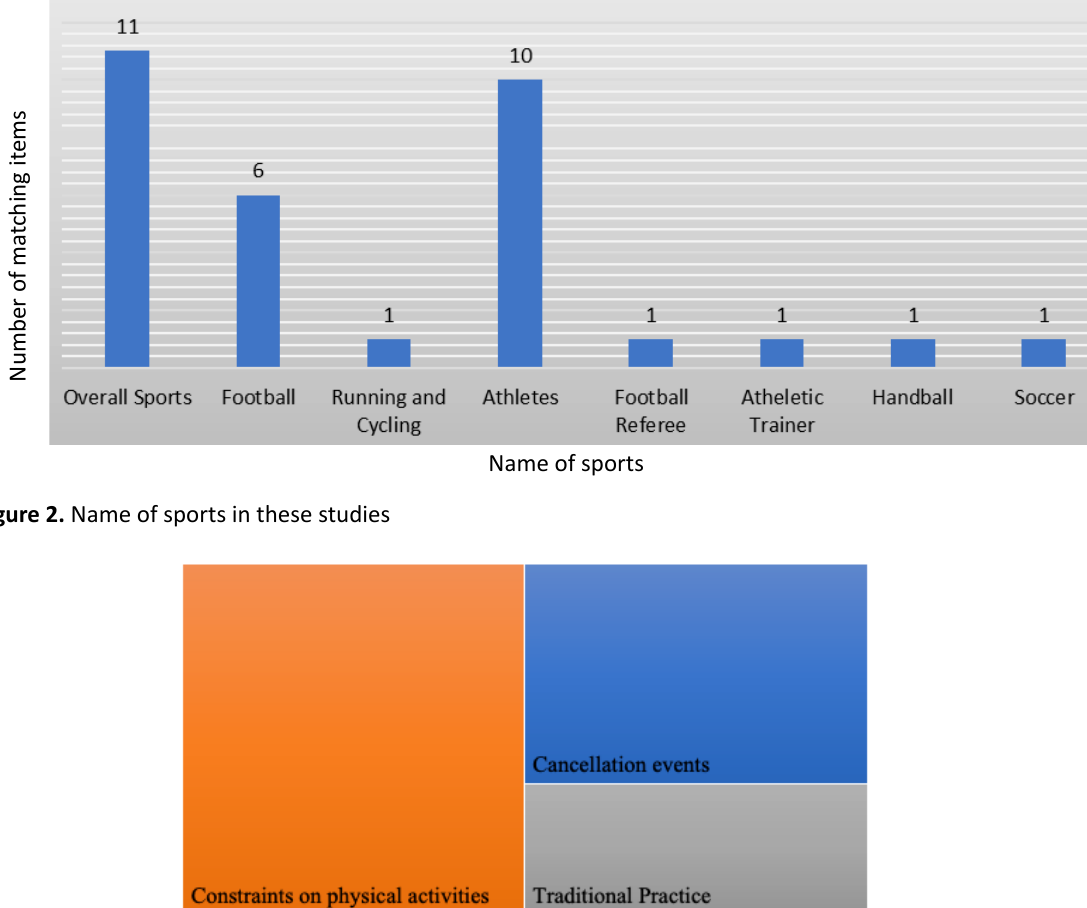
Figure 3. Impacts on sports activities in these studies